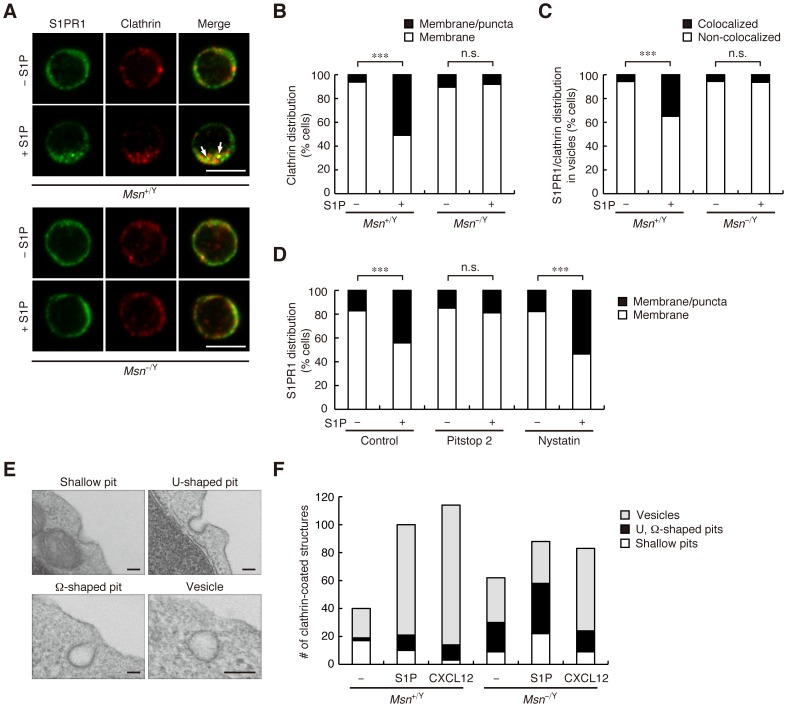
S1PR1 is internalized via a clathrin-dependent pathway.(A) S1PR1 and clathrin localization in CD4+ T cells. Lymph node CD4+ T cells from Msn
+/Y and Msn
−/Y mice were stimulated with or without 100 nM S1P for 1 h, fixed, permeabilized, and stained with anti-S1PR1 and anti-clathrin heavy chain. Representative confocal images are shown. Scale bars, 5 µm. Colocalization of S1PR1 and clathrin in vesicles is indicated by arrows. (B) Quantification of clathrin distribution. The percentages of cells with the indicated clathrin distribution pattern were determined. (C) Quantification of S1PR1 and clathrin colocalization. The percentage of cells with S1PR1 and clathrin colocalization in vesicles was determined. (D) The effect of pitstop 2 and nystatin on S1PR1 internalization. Lymph node CD4+ T cells from WT mice were pretreated with 5 µM pitstop 2 for 30 min or 25 µg/ml nystatin for 1 h, and then stimulated with 100 nM S1P for 1 h in the presence or absence of pitstop 2 or nystatin. Stimulated cells were fixed, permeabilized, and stained with anti-S1PR1. The percentages of cells with the indicated S1PR1 distribution patterns are shown. (E) Ultrastructural analysis of clathrin-coated structures. Representative examples of clathrin-coated structures observed at the CD4+ T cell plasma membrane are shown. Structures were grouped morphologically as shallow pits, U- or Ω-shaped pits, or vesicles. Scale bars, 100 nm. (F) Quantification of clathrin-coated structures observed along the perimeter of CD4+ T cells. Lymph node CD4+ T cells from Msn
+/Y and Msn
−/Y mice were stimulated with or without 100 nM S1P or 100 nM CXCL12 for 1 h, fixed, and analyzed by electron microscope. The total number of indicated structures along the perimeter of 25 cells per each group was determined. (B–D) n>50 cells for each group. ***, P<0.001; n.s., not significant (Fisher's exact test).